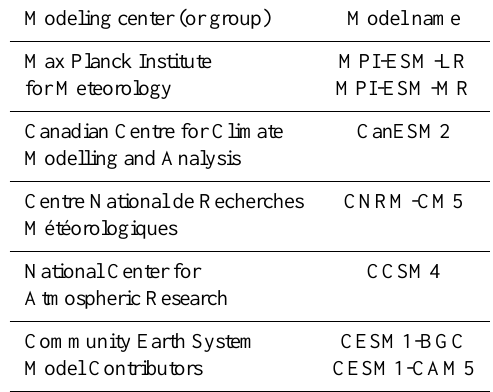
11 Table 4. Results of the multivariate regression of the conceptual coupled AMOC-NADO density system as in Eq. (4) to the individual models.